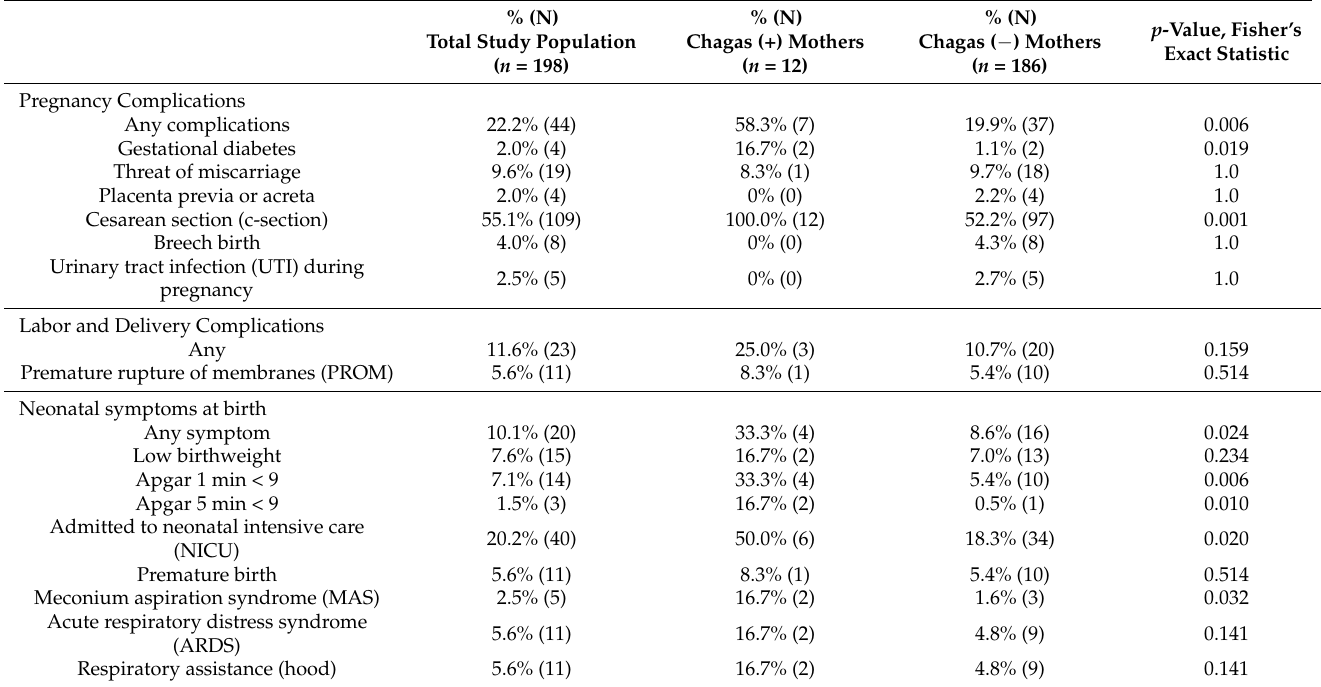
Table 2. Chagas disease positivity was associated with complications during pregnancy and neonatal symptoms at the time of